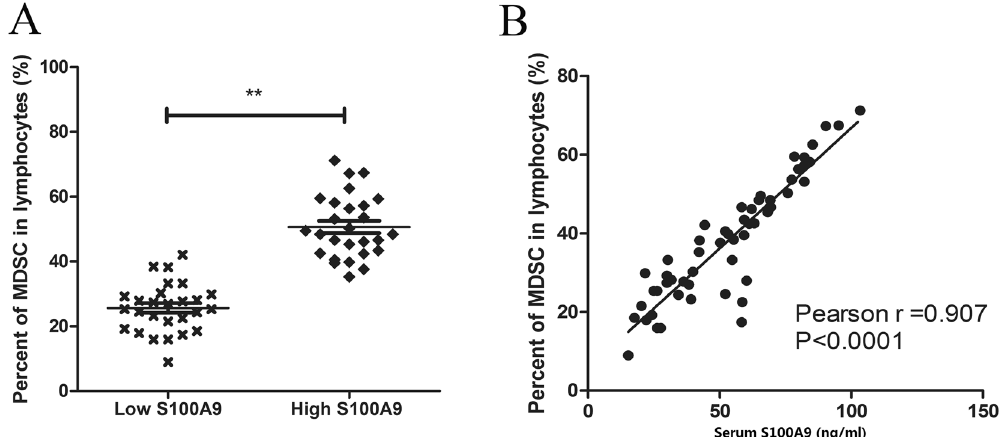
Figure 3. S100A9 was positively related to MDSCs in patients with NKTCL. ( A ) Patients with elevated levels of S100A9 (high-S100A9 group) possessed higher percentages of MDSCs than low-S100A9 group ( p < 0.01). ( B ) Percentage of MDSCs in peripheral blood was positively correlated with serum levels of S100A9 (Pearson r = 0.907, p < 0.0001). ** p <